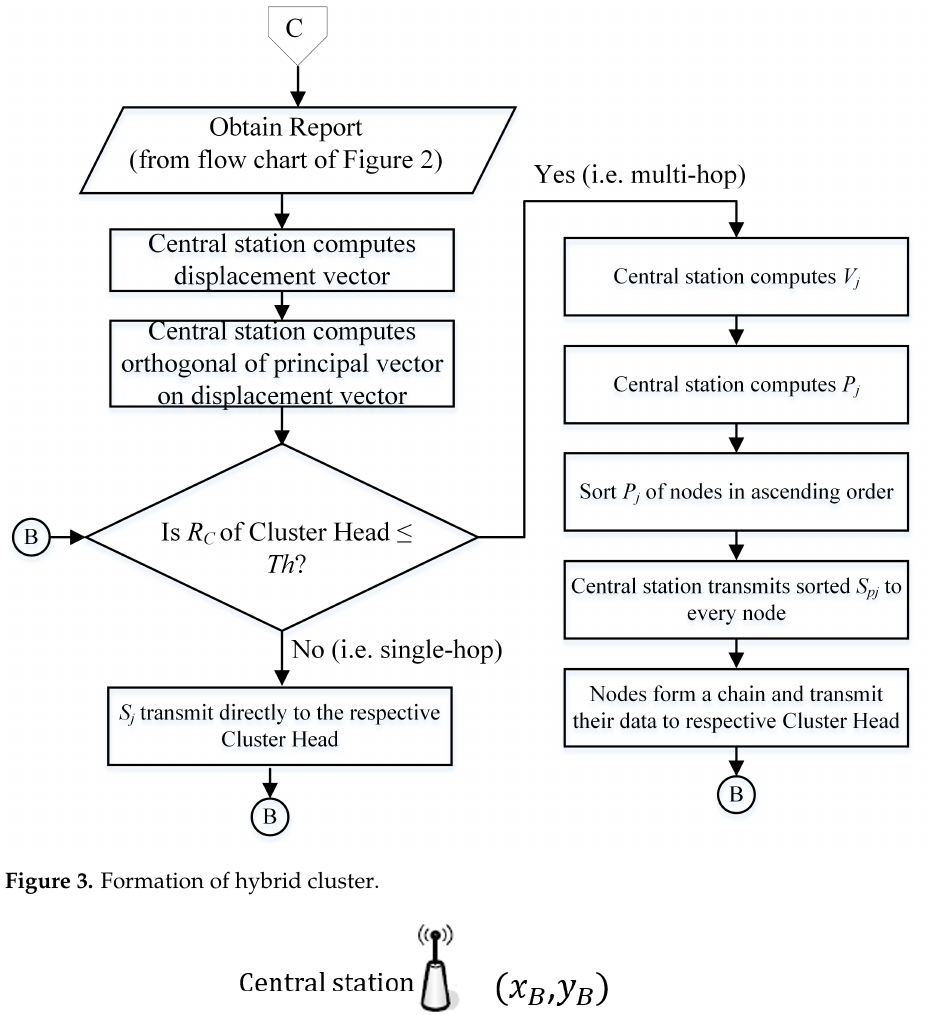
Figure 3. Formation of hybrid cluster.